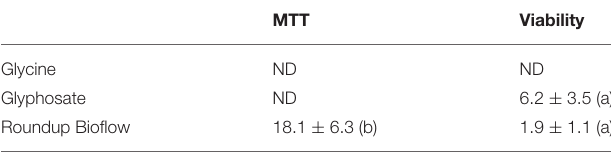
TABLE 2 | IC50 ( µ g/L) mean values calculated for MTT, viability on Caco2